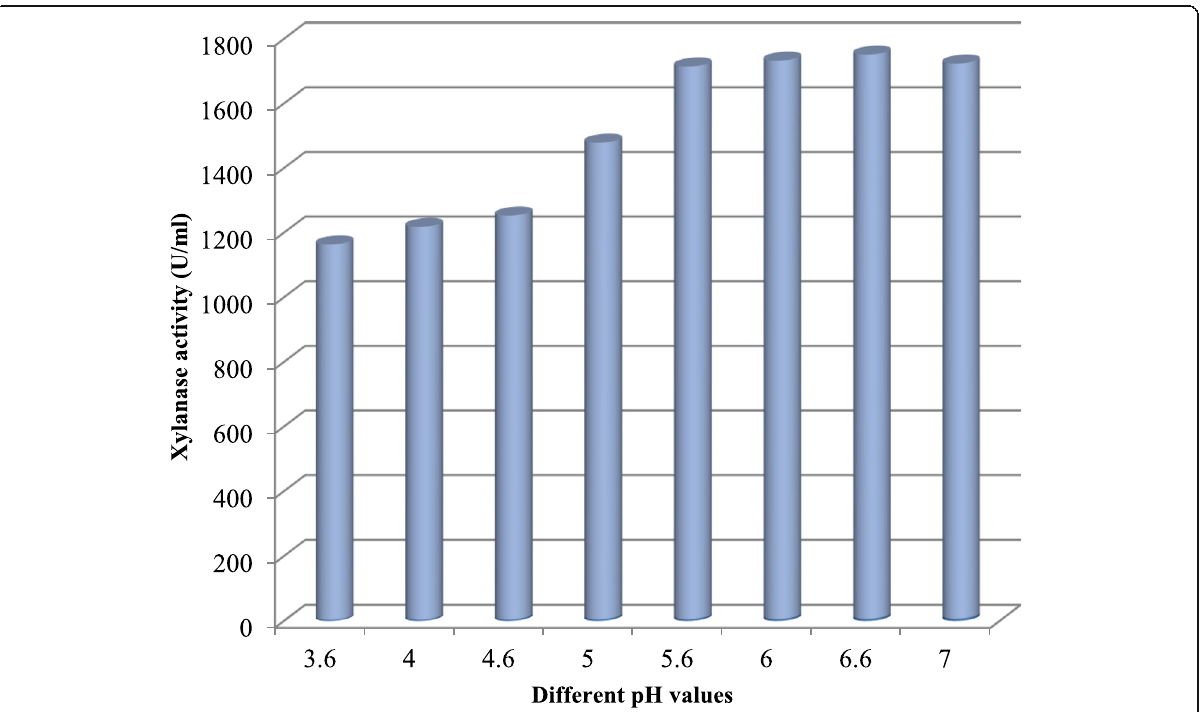
Fig. 7 Effect of different pH values on crude xylanase activity